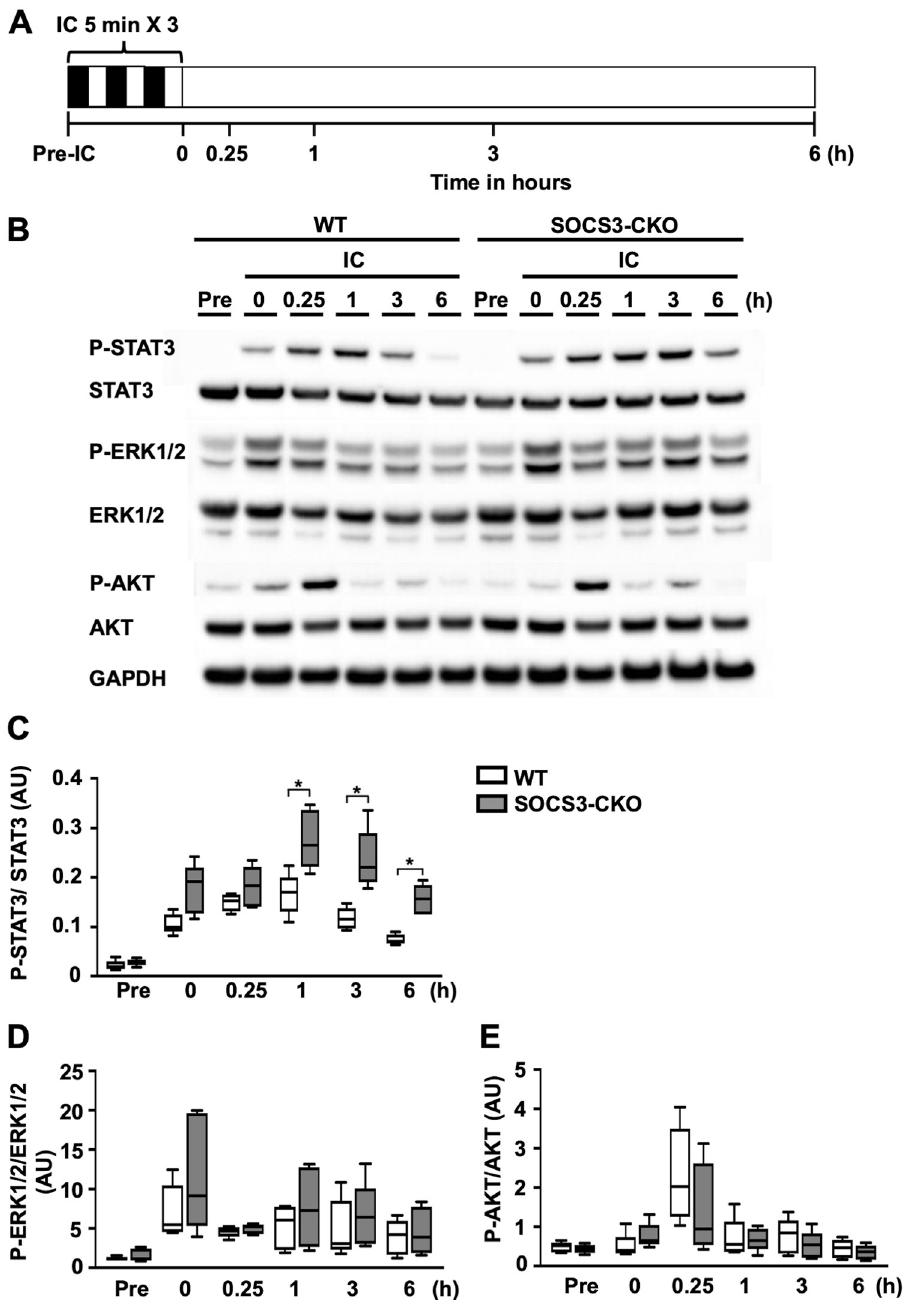
Fig 2. Sustained activation of STAT3 in SOCS3-CKO mice after ischemic conditioning alone. Western blot analysis of total cell lysates prepared from heart tissue of WT or SOCS3-CKO mice at the indicated time-points after IC. ( A ) Schematic illustration depicting the experimental protocol. ( B) Blots were probed using antibodies against phosphorylated STAT3 (P-STAT3), total STAT3, phosphorylated AKT (P-AKT), total AKT, phosphorylated ERK1/2 (P-ERK1/2), total ERK1/2, and GAPDH. ( C) , ( D) , and ( E) Graphs display the quantitative differences in the ratios of the expression of P-STAT3 to total STAT3 ( C ), P-ERK1/2 to total ERK1/2 ( D ), and P-AKT to total AKT ( E ) (n = 5 per group). � p < 0.05, �� p < 0.01 (Wilcoxon rank-sum test). WT, wild-type; IC, ischemic conditioning; AU, arbitrary units; GAPDH, glyceraldehyde 3-phosphate dehydrogenase.